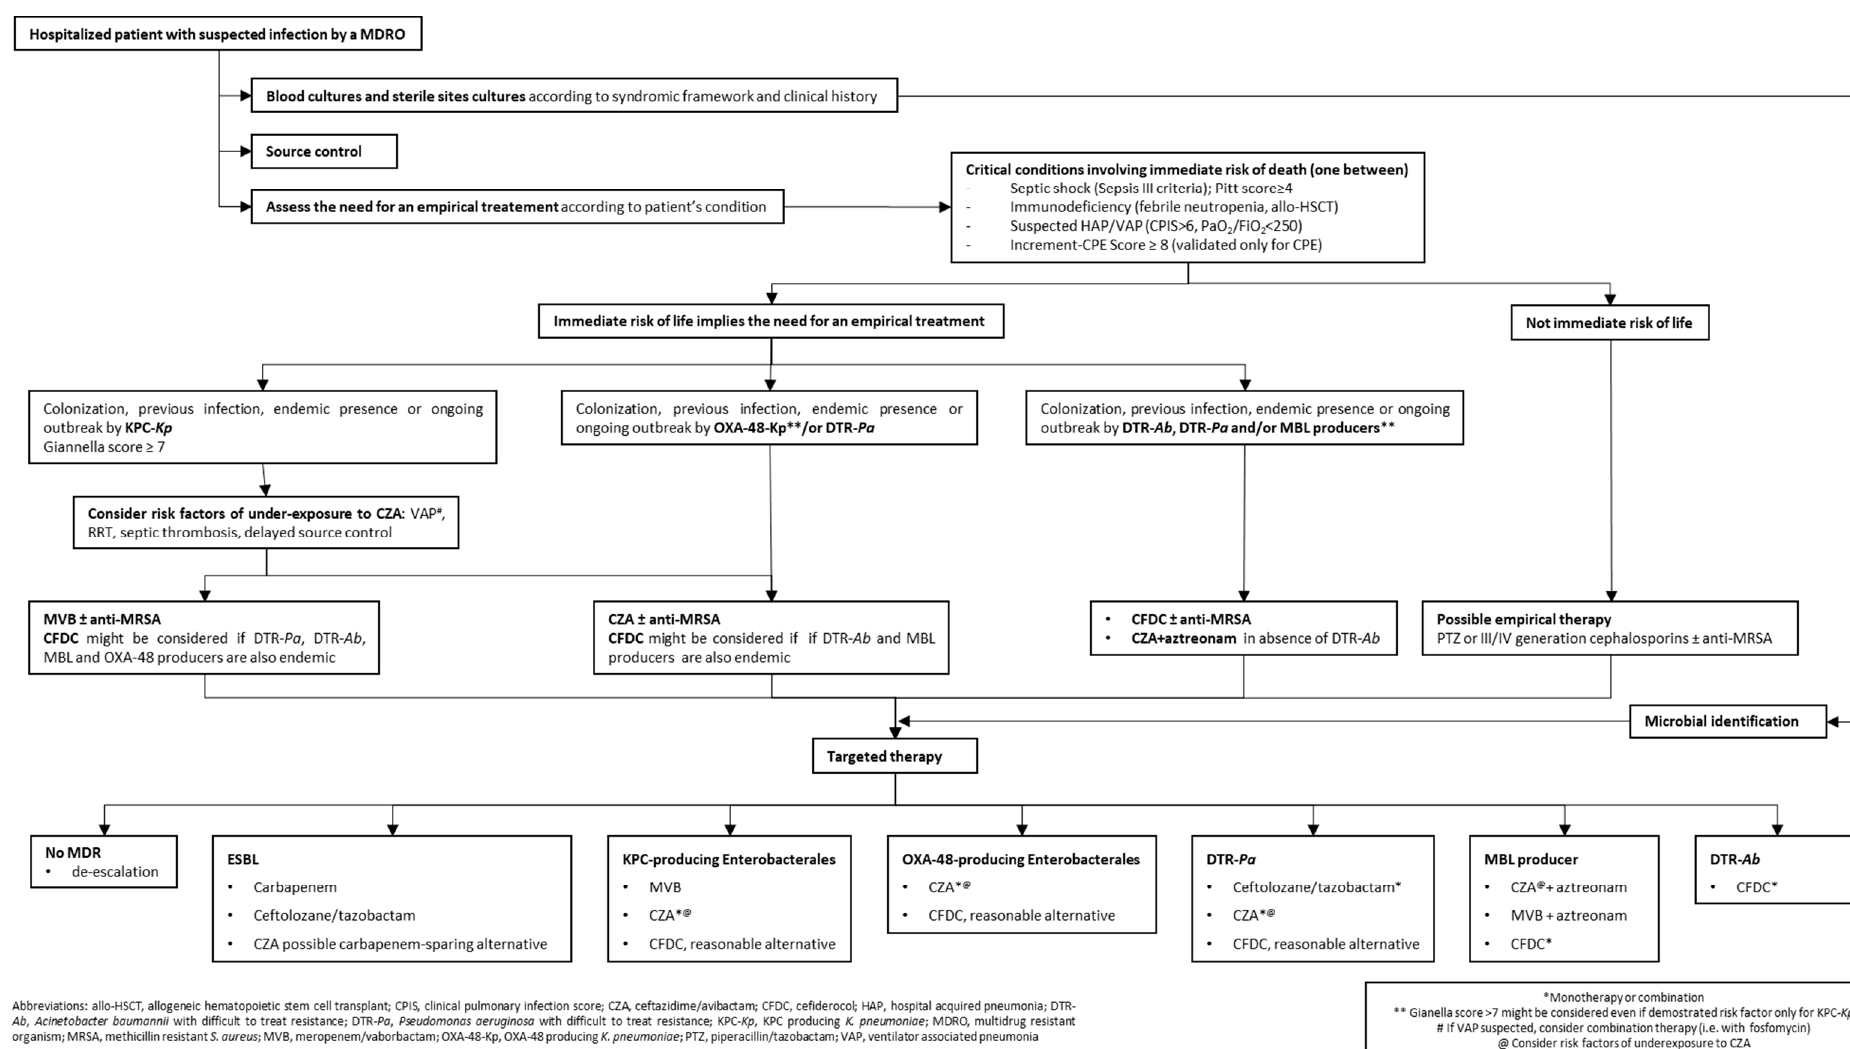
Figure 1. Algorithm for a reasoned prescription of new antimicrobials.